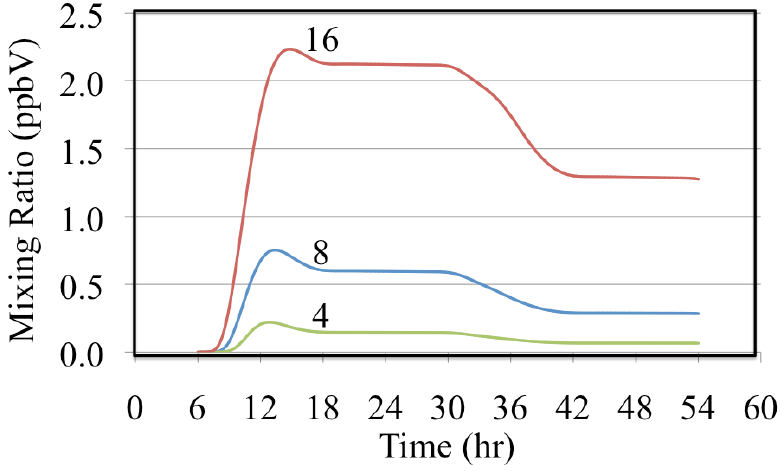
Figure 14. Organic peroxide mixing ratios are shown for the ethene cases. The number indicates the initial VOC/NO ratio in x